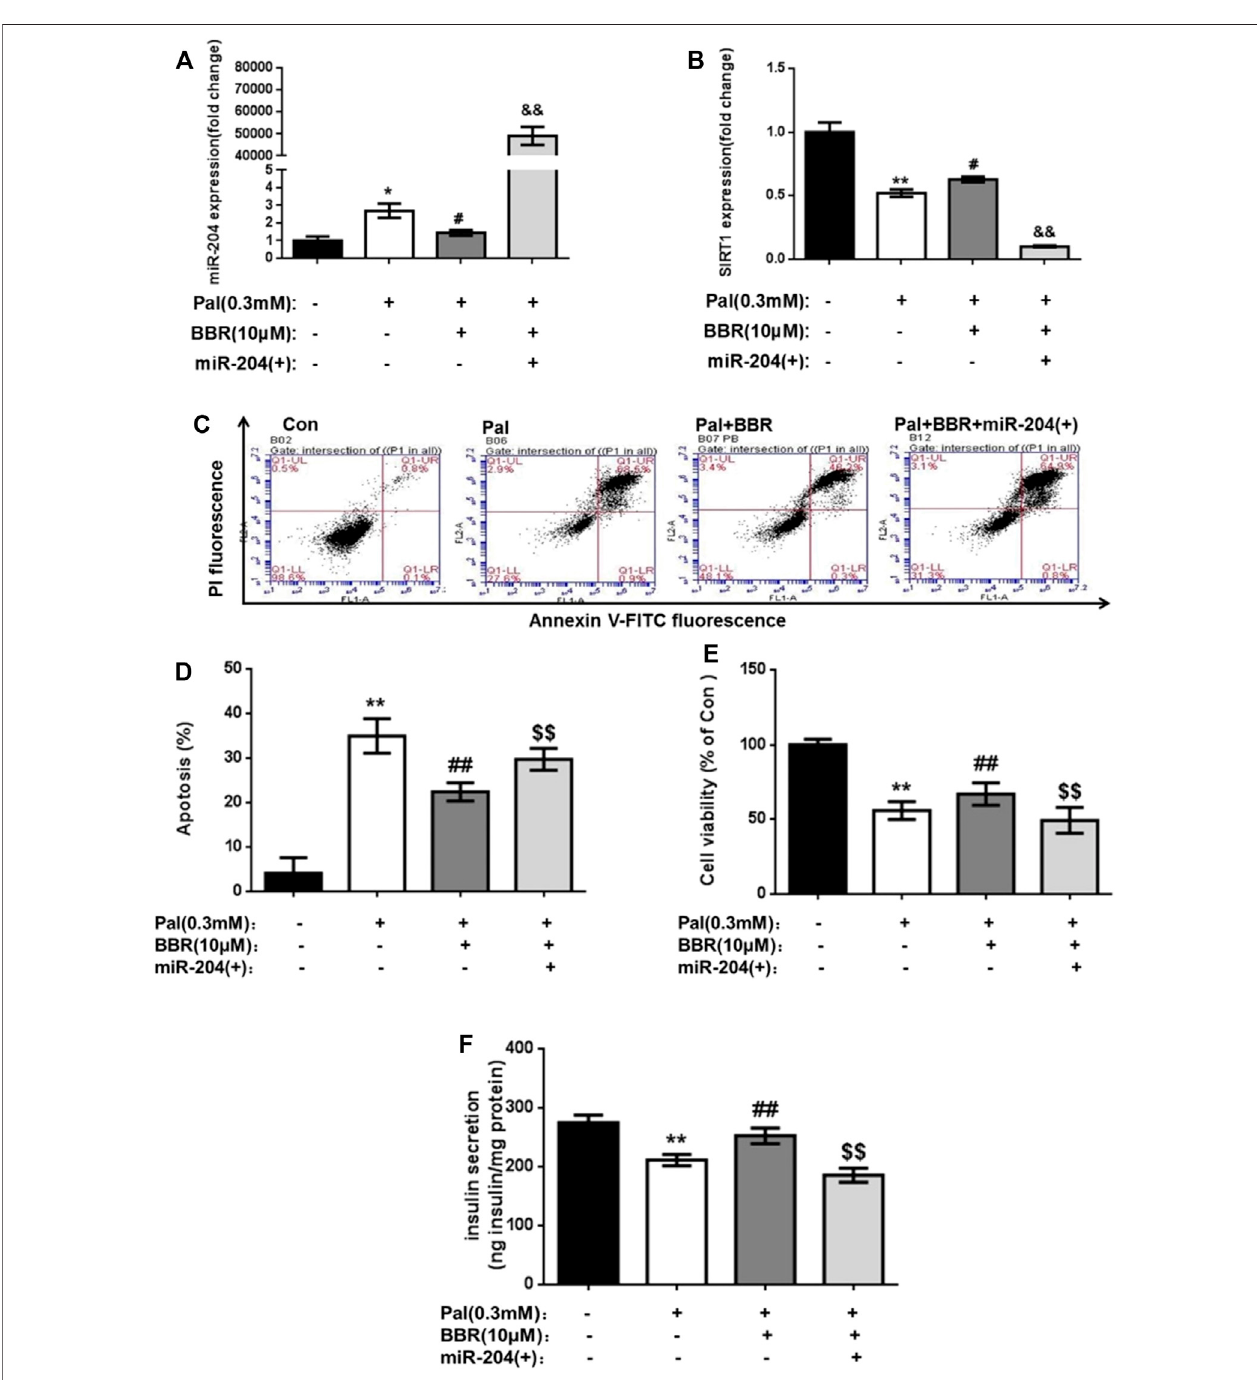
FIGURE 7 | BBR may relieve the PA impairment on MIN6 cells via miR-204/SIRT1 pathway. After using BBR (10 μ M) to treat PA-induced apoptotic and miR-204 overexpressed MIN6 cells for 24 h, the RNA of cells was extracted, and miR-204 expression (A) and SIRT1 expression (B) were measured by RT-PCR. (C, D) The apoptosis was observed and analyzed by fl ow cytometry (E) The in fl uence on the survival rate of MIN6 cells were assessed by MTT assay. (F) Basal insulin release and content were measured in MIN6 cells. Data was expressed as means ± SEM ( n (cid:1) 6). * p < 0.05, ** p < 0.01 compared with Con group; # p < 0.05, ## p < 0.01 compared with Pal group; $$ p < 0.01 compared with Pal + BBR